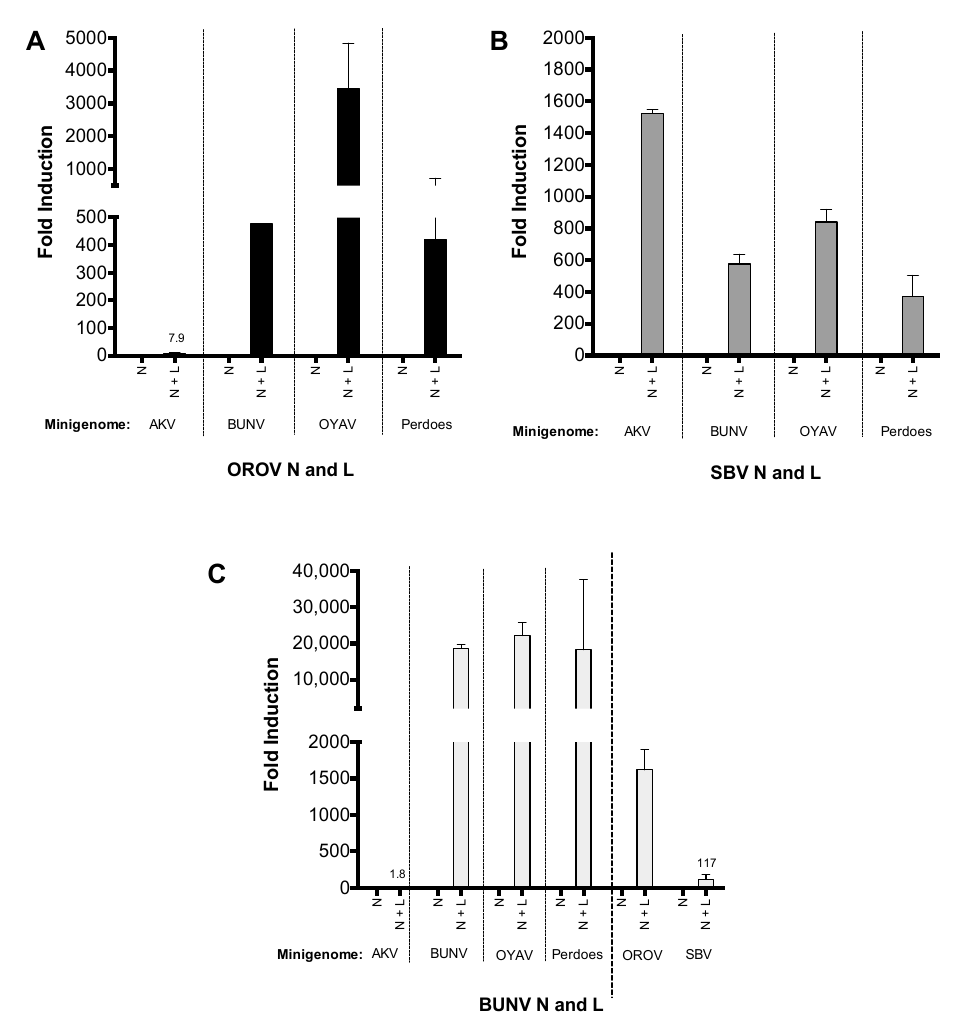
Figure 5. Simbu M-minigenome comparison ( A – C ) BSR-T7/5 cells were transfected with pTM1-N and/or pTM1-L (250 ng) and M-minigenome (125 ng) plasmids. Firefly luciferase-expressing pTM1-FF-Luc (25 ng) served as a transfection control. Renilla and firefly luciferase were measured using a Dual-Luciferase Reporter Assay kit (Promega) 24 h p.t. Luciferase values were normalized and minigenome-activity expressed as fold-induction over background control (no pTM1-L). Error bars indicate SD ( n = 3).